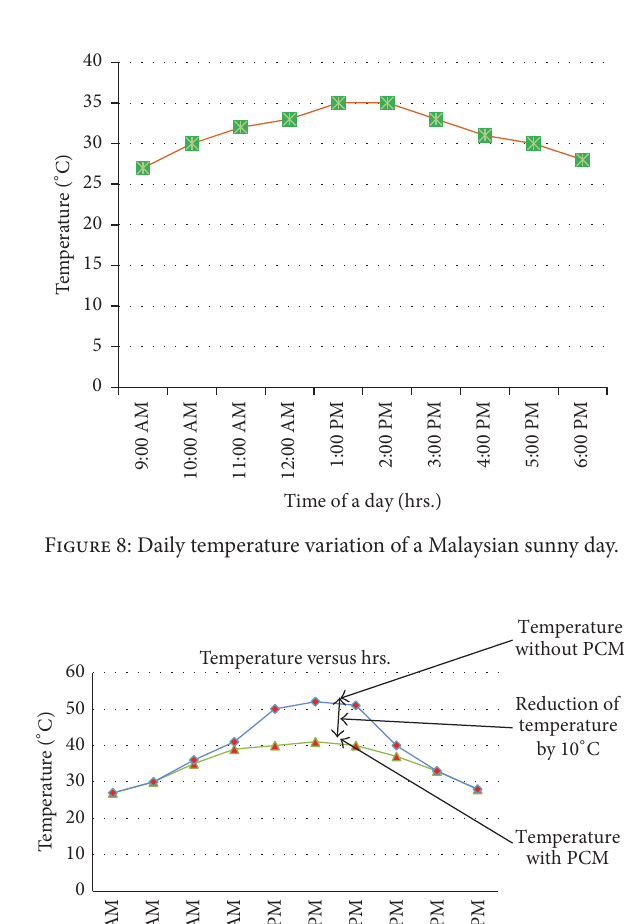
Temperature with PCM